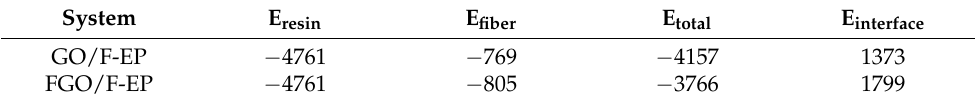
Table 2. Binding energy of different modified graphene/F-EP systems (kcal/mol). System